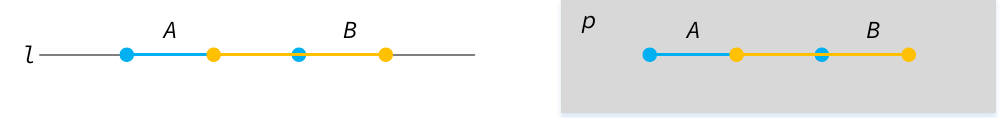
Figure 4. The topological spatial relations for the same configuration when embedded in a different topological